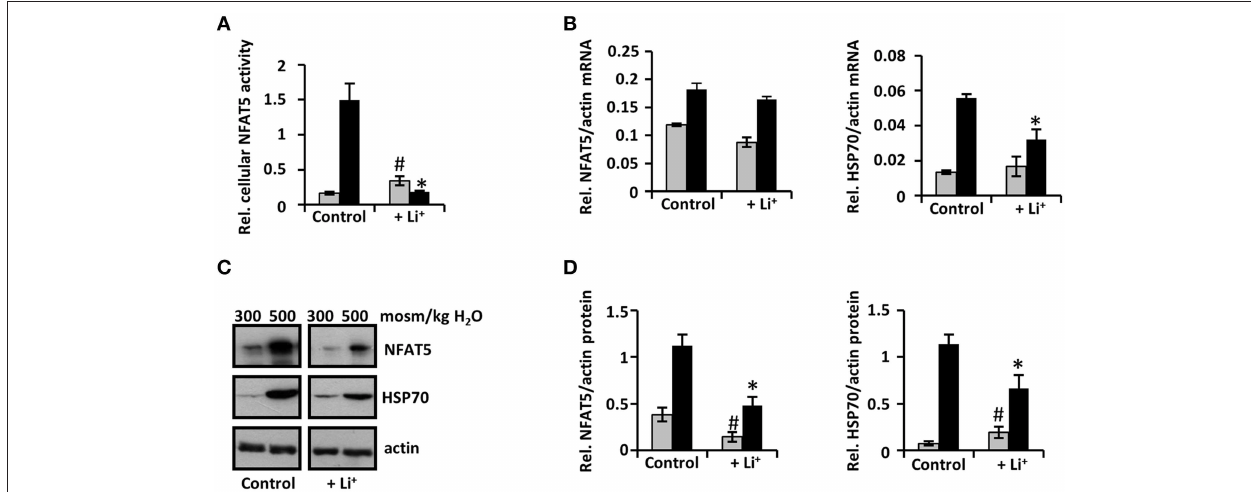
FIGURE 5 | Long-term exposure to lithium decreases cellular NFAT5 activity. HEK 293 cells stably transfected with a reporter construct in which the SEAP gene is under control of two TonE sites (A) or IMCD-3 cells (B–D) were incubated for 96h in isosmotic ( ; 300 mosm/kg H 2 O) or hyperosmotic ( (cid:4) ; 500 mosm/kg H 2 O) medium and exposed to 10mM Li 2 SO 4 or 10mM Na 2 SO 4 (as control). (A) After 96h, SEAP activity was measured as described in Methods. Data are means ± SEM for n = 6 ; * P < 0.05 vs. hyperosmotic control; # P < 0.05 vs. isosmotic control. (B) IMCD-3 cells were processed for RNA extraction and the abundance of NFAT5 and HSP70 mRNA transcripts was determined by qRT-PCR. Relative mRNA abundance was normalized to that of β -actin to correct for differences in RNA input. Data are means ± SEM for n = 4 ; * P < 0.05 vs. hyperosmotic control; # P < 0.05 vs. isosmotic control. (C) IMCD-3 cells were processed for immunoblotting. To demonstrate comparable protein loading, the blots were also probed for actin. A representative blot from four independent experiments is shown. (D) Relative protein abundance of NFAT5 and HSP70 was quantified by densitometric analysis of immunoblots and normalized to that of actin to correct for differences in protein loading. Data are means ± SEM for n = 4 ; * P < 0.05 vs. hyperosmotic control; # P < 0.05 vs. isosmotic